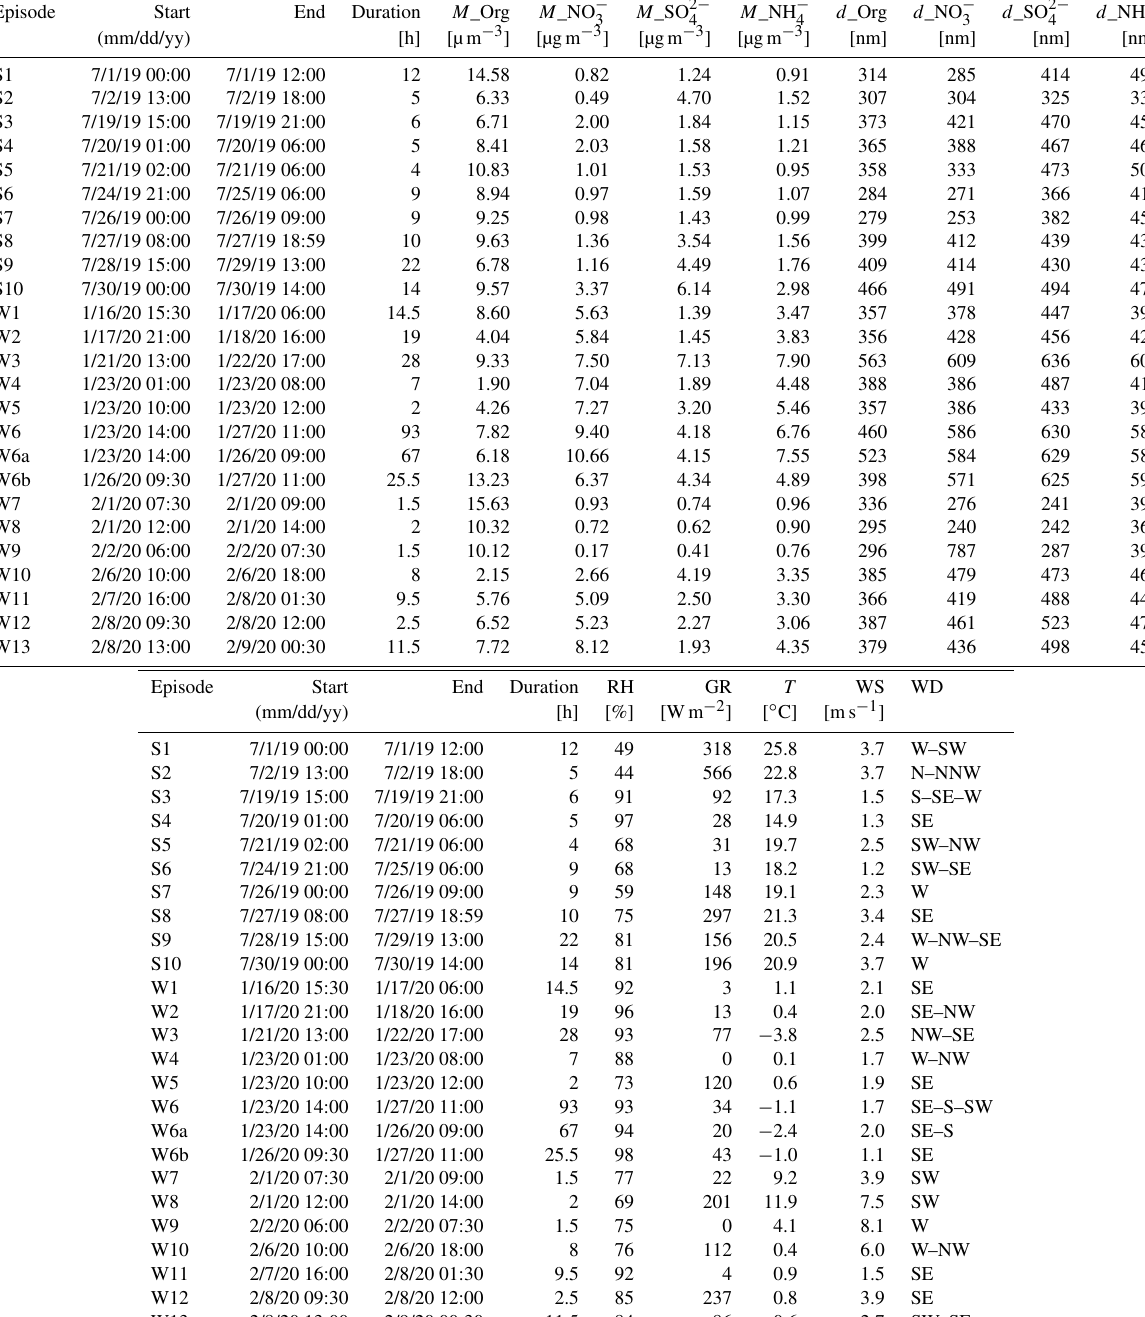
Table A1. Overview table presenting mass ( M ) and median diameter ( d ) of NR-PM 1 species calculated by fitting log-normal function to the AMS size distributions for the selected episodes in summer (S1–S10) and winter (W1–13) along with meteorology recorded during the episodes (relative humidity – RH, global radiation – GR, temperature – T , wind speed – WS, and wind direction –